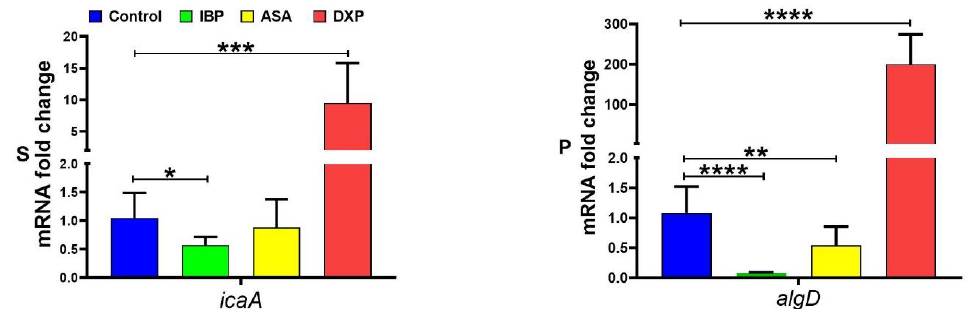
Figure 6. S: The transcriptional level of icaA in S. aureus with and without the sub-MIC levels of IBP (200 µg/mL), ASA (200 µg/mL), and DXP (500 µg/mL). P: The transcriptional level of algD in P. aeruginosa with and without the sub-MIC levels of IBP (200 µg/mL), ASA (200 µg/mL), and DXP (500 µg/mL). Graphs were drawn based on fold changes in transcriptional levels of icaA and algD in clinical isolates of S. aureus and P. aeruginosa , respectively. Data are displayed as the mean ± standard error of the mean from 3 replicate experiments and were analyzed using the ANOVA test. *, statistical significance with p ≤ 0.05; **, statistical significance with p ≤ 0.01; ***, statistical significance with p ≤ 0.001 ; and ****, statistical significance with p ≤ 0.0001.